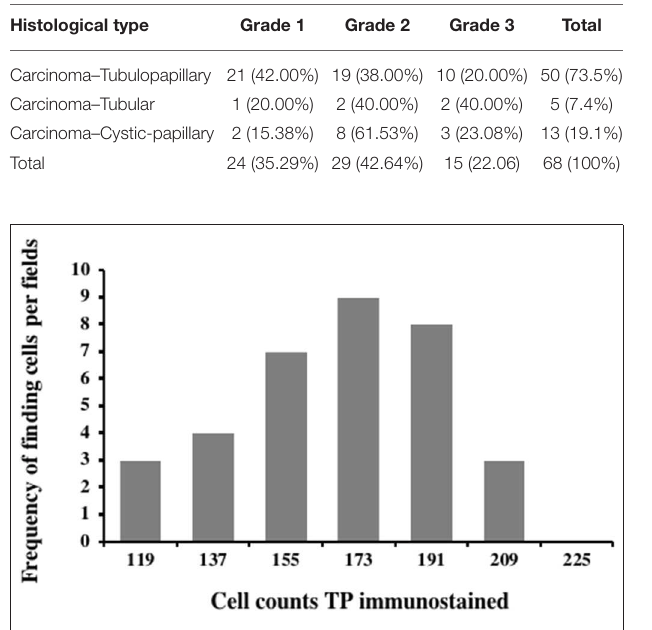
TABLE 5 | Carcinoma-Simple types gradation.